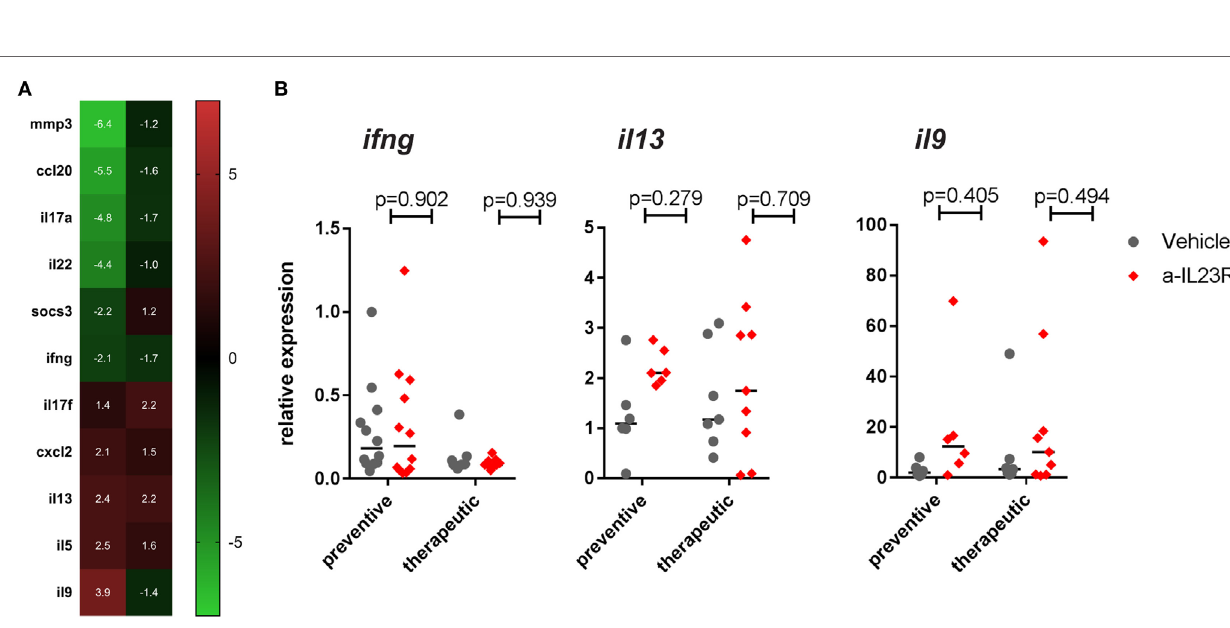
FigUre 6 | Th17 gene regulation in popliteal LN from prophylactically versus therapeutically treated rats. (a) Top genes ( > 2-fold up- or downregulated) in aIL23R treated versus control rats (data are fold change aIL23R versus vehicle). (B) Confirmation by qPCR on all samples for Th1/Th2 cytokines IFN- γ , IL-13, and IL-9 (individual data points and median are